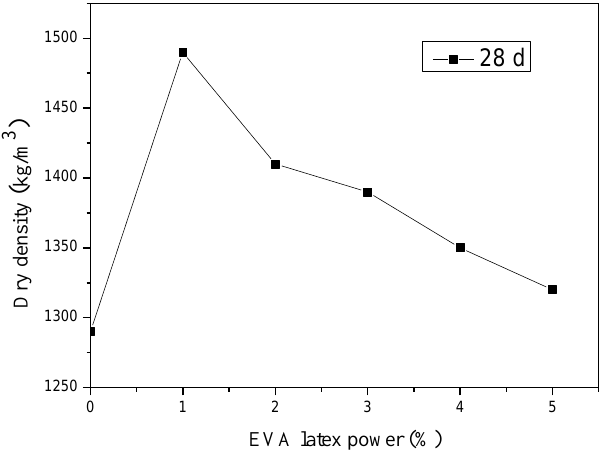
Figure 6. Effect of EVA on the dry density of mortar.